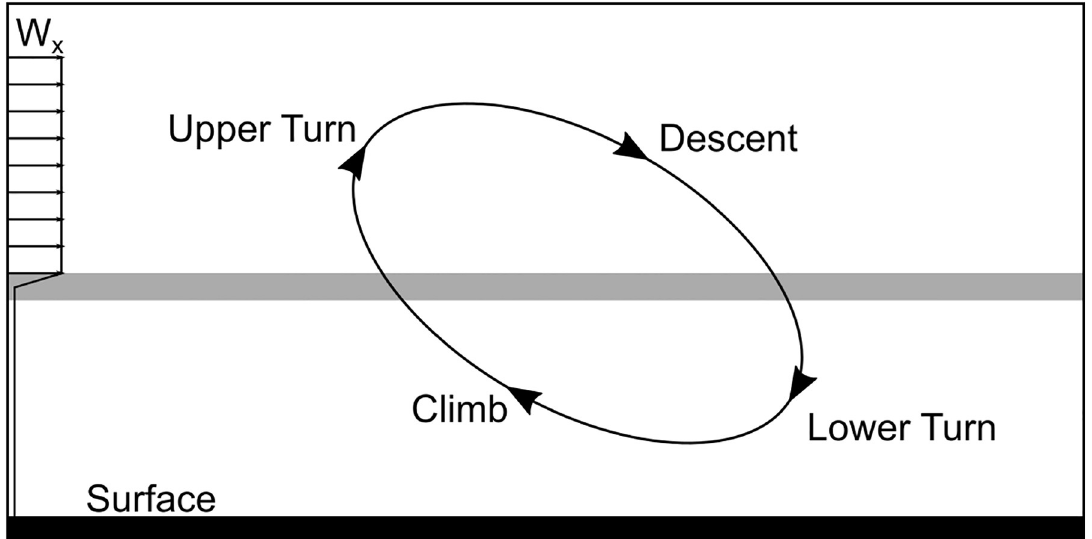
Fig 1. Rayleigh cycle. Schematic representation of the Rayleigh